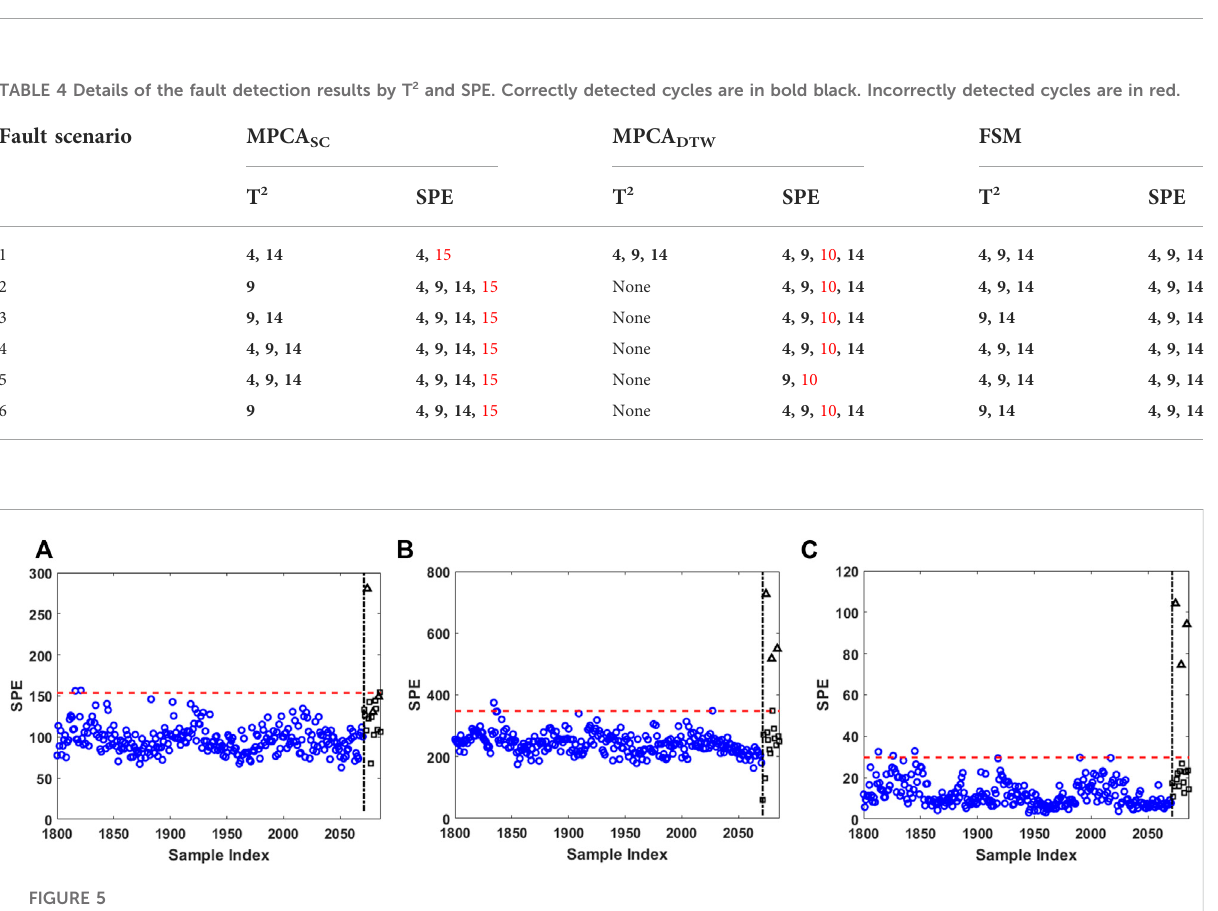
FIGURE 5 Fault scenario 1: fault detection in residual subspace (SPE) from (A) MPCA SC (B) MPCA DTW and (C) FSM. Blue circles are normal training cycles; black squares are normal testing cycles; black triangles are faulty testing cycles; horizontal red dashed lines are fault detection thresholds; vertical black dash-dotted lines separate training from